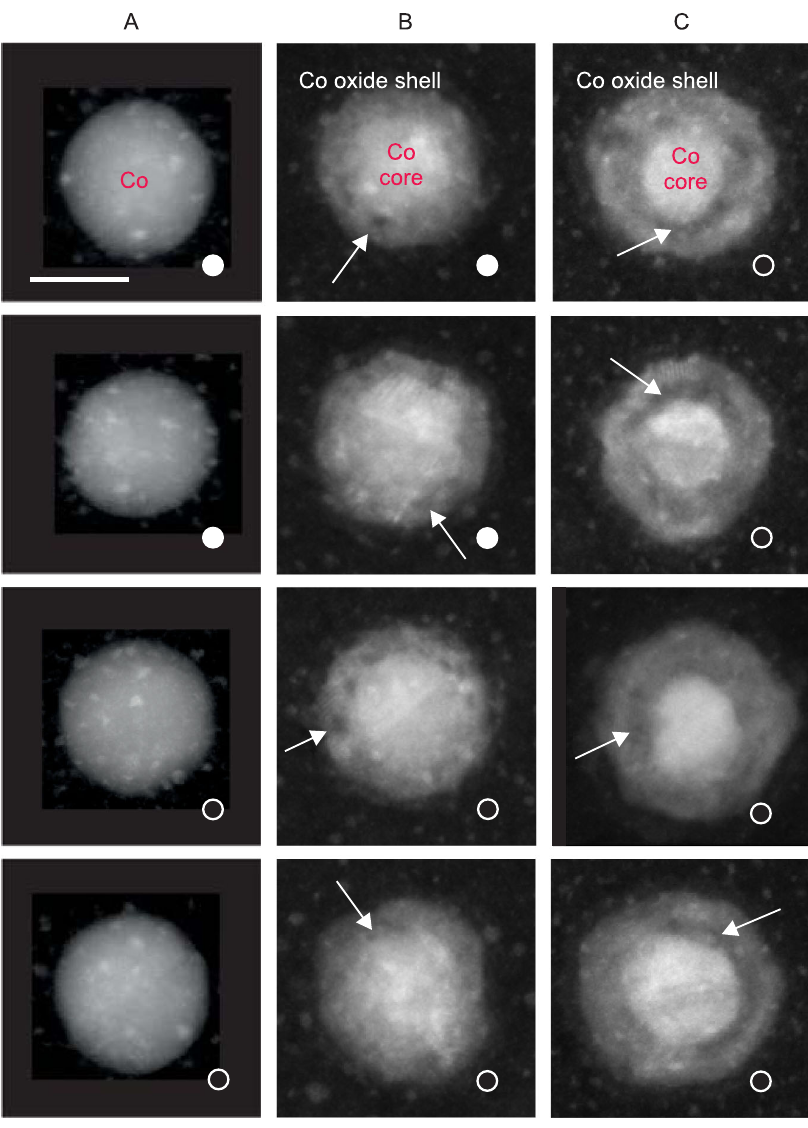
Fig. 3 | High-angle annular dark- fi eld scanning transmission electron micro- scopy (HAADF-STEM)imagesofcarbon-cappedCo nanoparticlesinstatesA – C on Si 3 N 4 membranes (corresponding respectively to 0L, 1L, and 20L on Si/ SiO x ofFig.2). Themicrographsineachcolumncorrespondtothesameoxidation